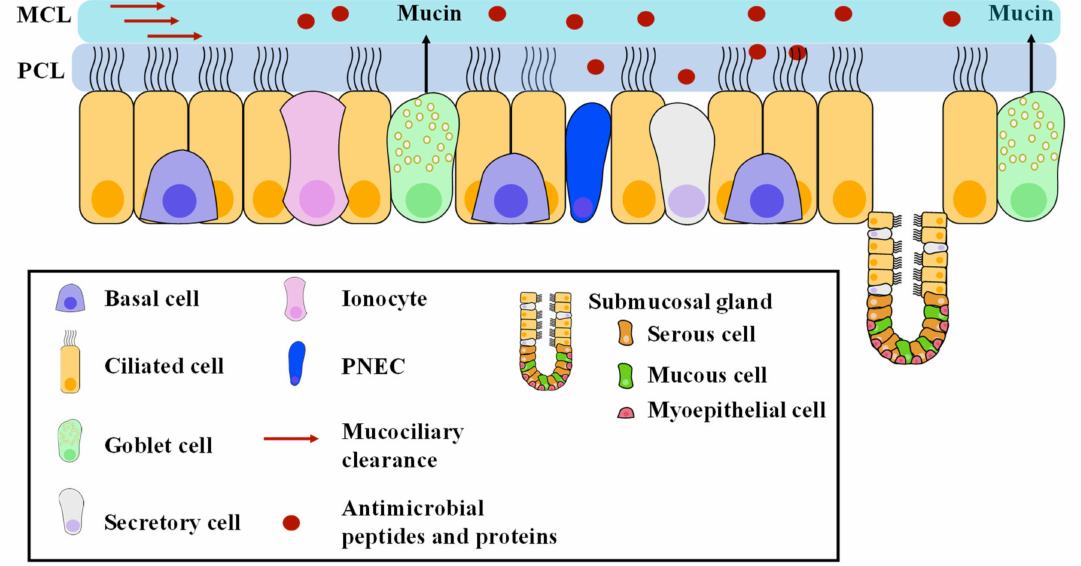
Figure 2. Pseudo-stratified airway epithelium and physiological role of main cells. Regulation of ASL composition and mucociliary clearance is critical for normal airway function. The ASL is a ~10 µ m bilayer made up of a periciliary liquid (PCL) and a mucus layer (MCL). The PCL is a watery layer which bathes the cilia, and is in direct contact with the epithelial cells. The MCL is a gel-like layer sitting over the tips of the cilia. The PCL allows the cilia to beat and strike at the underside of the MCL. Whereas the PCL is composed of 96% water, 1% salts, 1% lipids, 1% proteins, and 1% mucus [2,8], the MCL layer is a heterogeneous mixture of polypeptides and cellular debris tethered together on the PCL surface by MUC5AC and MUC5B complexes [9–11]. It is thought that the mucous layer acts as a fluid reservoir to maintain ASL hydration